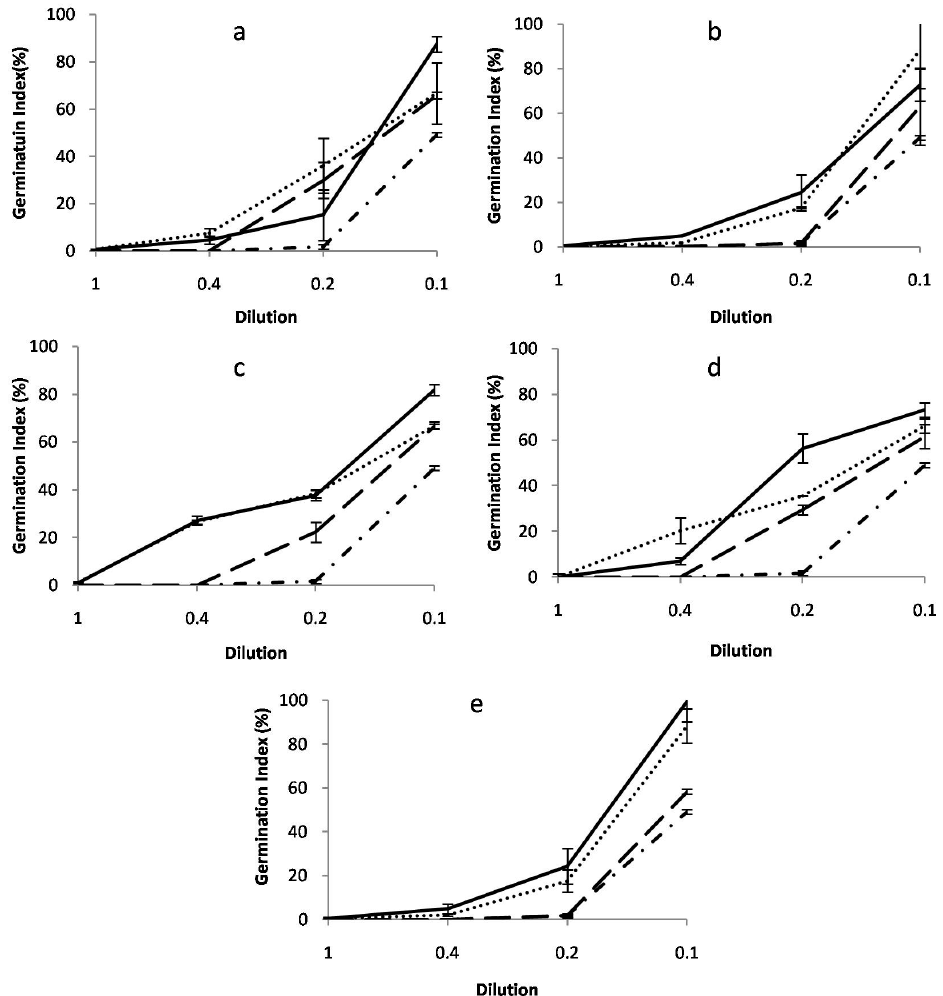
Figure 5. Phytotoxicity effects of PAHs and HMs on L. sativum , expressed as the germination index (GI) at 48 h after treatment with PAHs (solid line), PAHs and HMs (dotted line), inactivated mycelium (long-dash line), and untreated PAHs and HMs (dotted dash line), with ( a ) C. jodhpurense , ( b ) C. maderasense , ( c ) P. variabile , ( d ) E. lacerata , and ( e ) P. betae . Error bars indicate the average of tree replicates (n = 3).